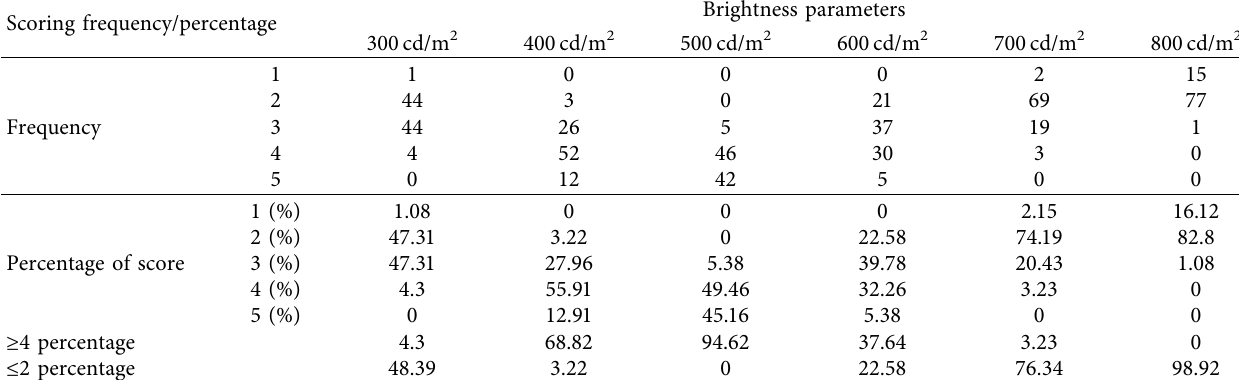
Table 2: Statistical frequency percentage of visual acuity data.